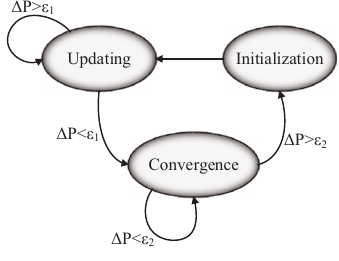
Figure 19. State diagram for dynamic tracking process with GSS and NQI.